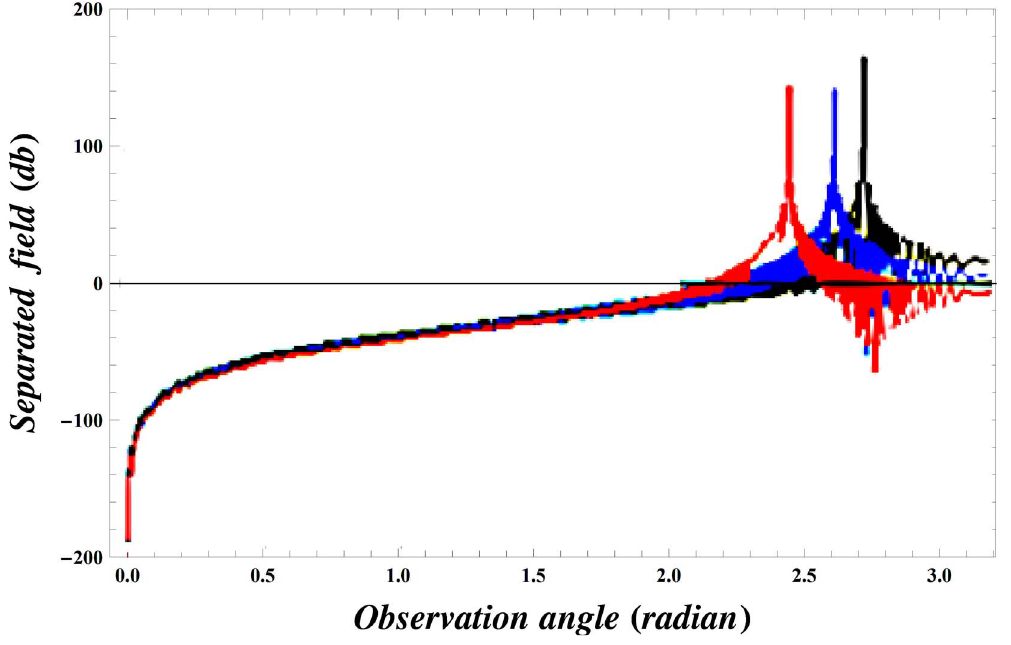
Figure 12. Separated field versus observation angle for values of k , b 1 and h 0 with plate length l ~ 1000 .